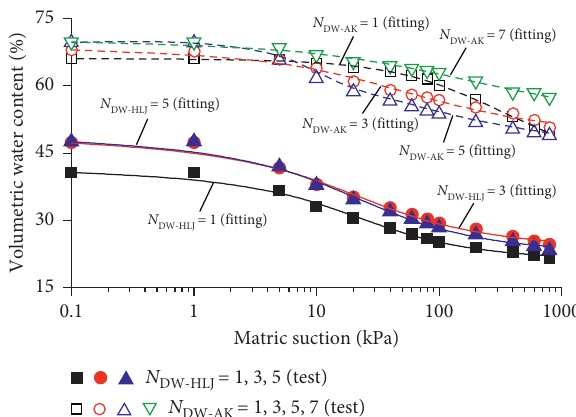
Figure 13: Relationships between parameters of Gardner model and the time of the dry-wet